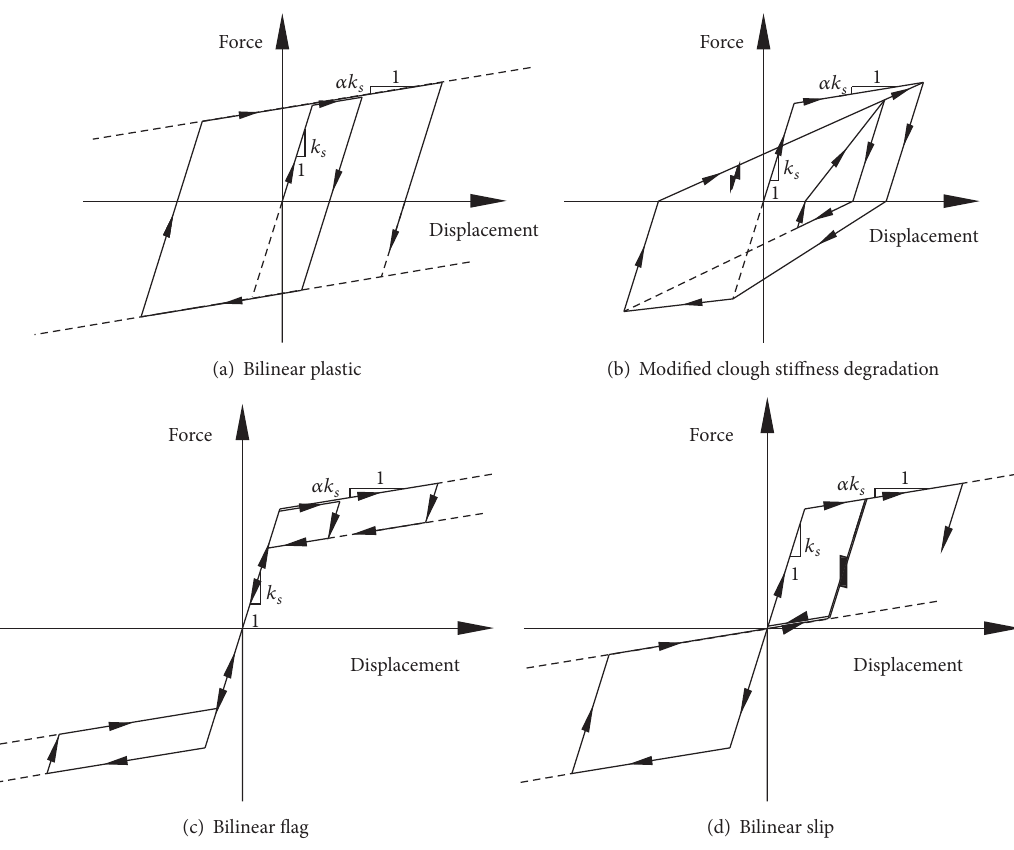
Figure 1: Hysteresis